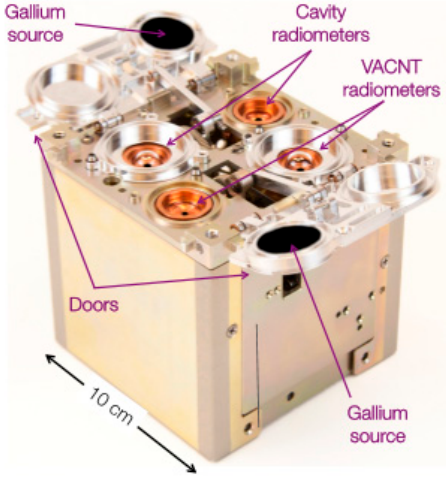
Figure 3. RAVAN Payload (1U Dimensions, 1 kg weight) (NASA, 2016) [9].